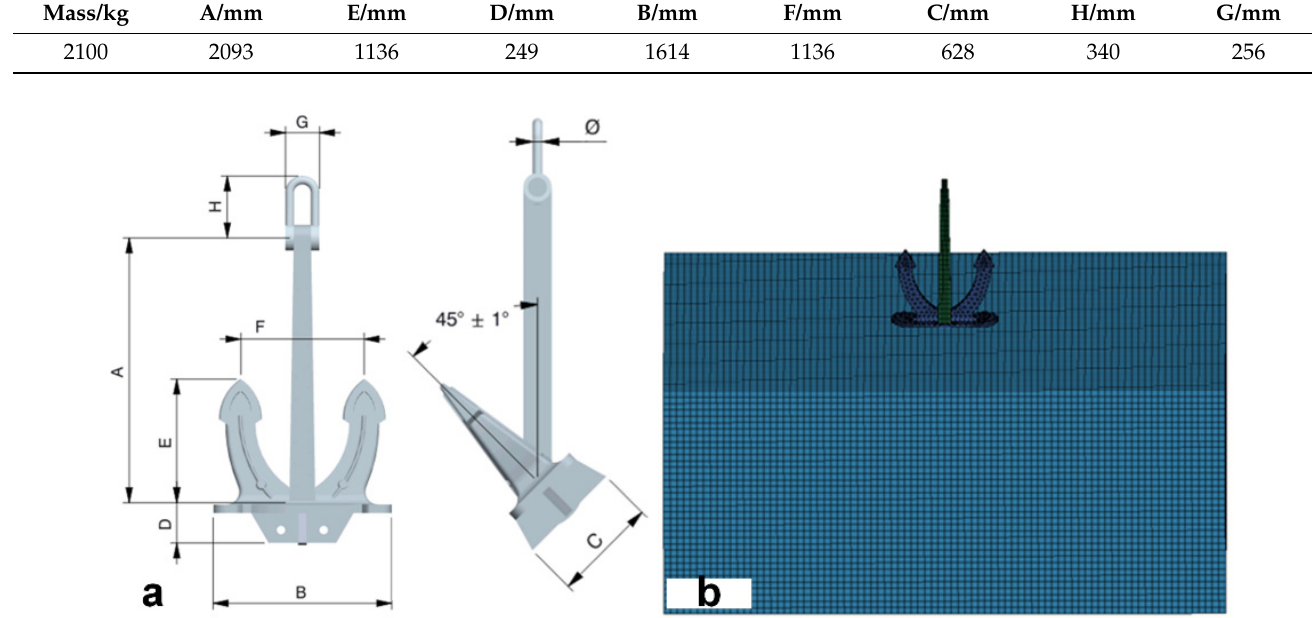
Table 4. The specifications of Hall anchor.